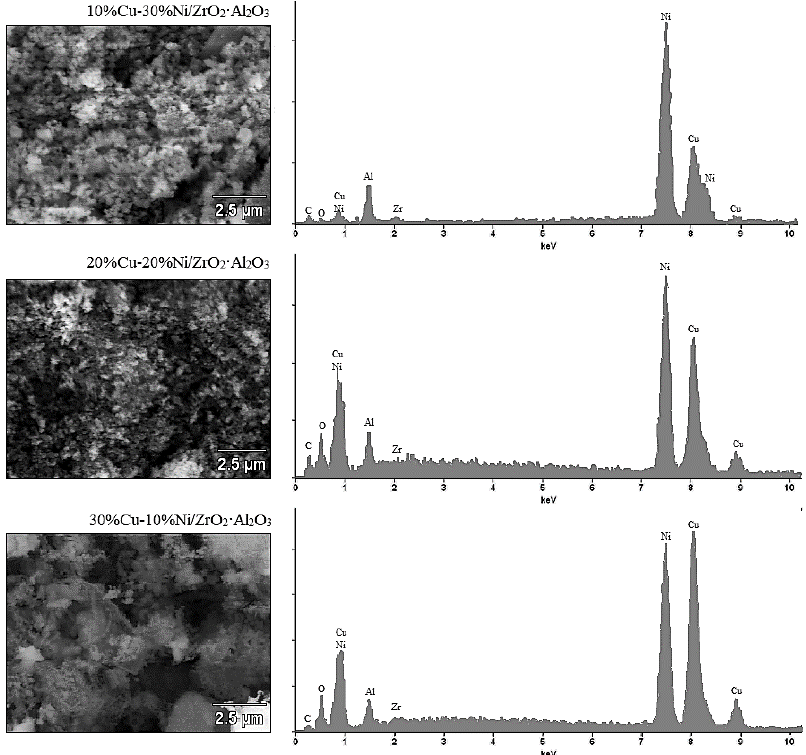
Figure 10. Scanning electron microscope images and EDS spectra collected for the investigated bimetallic x Cu - y Ni/ZrO 2 ·Al 2 O 3 catalysts (where x (y) = 10, 20 and 30 wt.%).